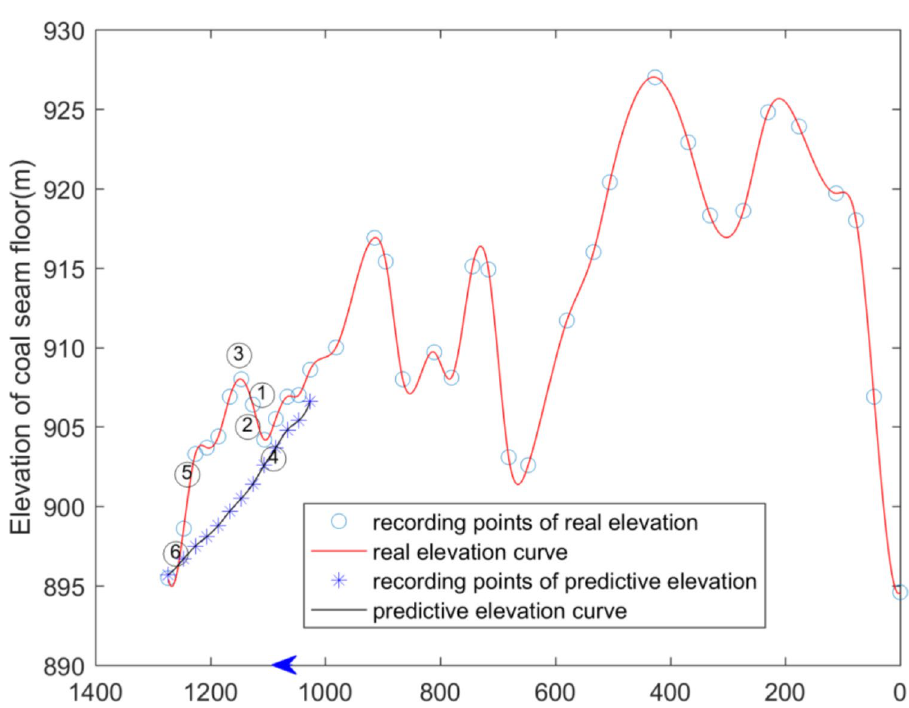
Figure 9. Curve of coal seam floor of air-return roadway (The blue * represents the elevation point calculated by surface spline function. The blue ◦ represents the real elevation point exposed by drivage. The arrow represents the direction of laneway excavation. The symbol ① ~ ⑥ are interpreted in the Table